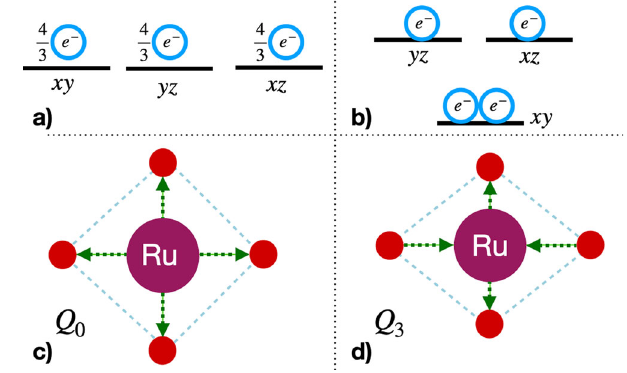
Fig. 7 Schematic of the electronic and structural disproportionation characterizing the metal – insulator transition of Ca 2 RuO 4 . a In the metallic phase, all 3 t 2 g orbitals of Ca 2 RuO 4 are approximately equally occupied; Δ N ≈ 0. b In the insulating phase, the xy orbital is doubly occupied, while the yz and xz are singly occupied; Δ N = 1. c Representation of Q 0 structural mode, in which all bond lengths change equally. d Representation of structural mode Q 3 in which octahedral volume is preserved and the change in the two in-plane Ru – O bond lengths are equal, and opposite in sign to the change in the apical bond length. The electronic state in b is associated with a structural term of the form − ( Q 3 − λ 0 Q 0 ), with λ 0 > 0 Legend: a , b : black lines correspond to orbital energy levels, blue circles signify electrons; c , d : purple circle = Ru atom, red circle, O atom; arrows and dotted lines signify bonds and their changes with the two different structural